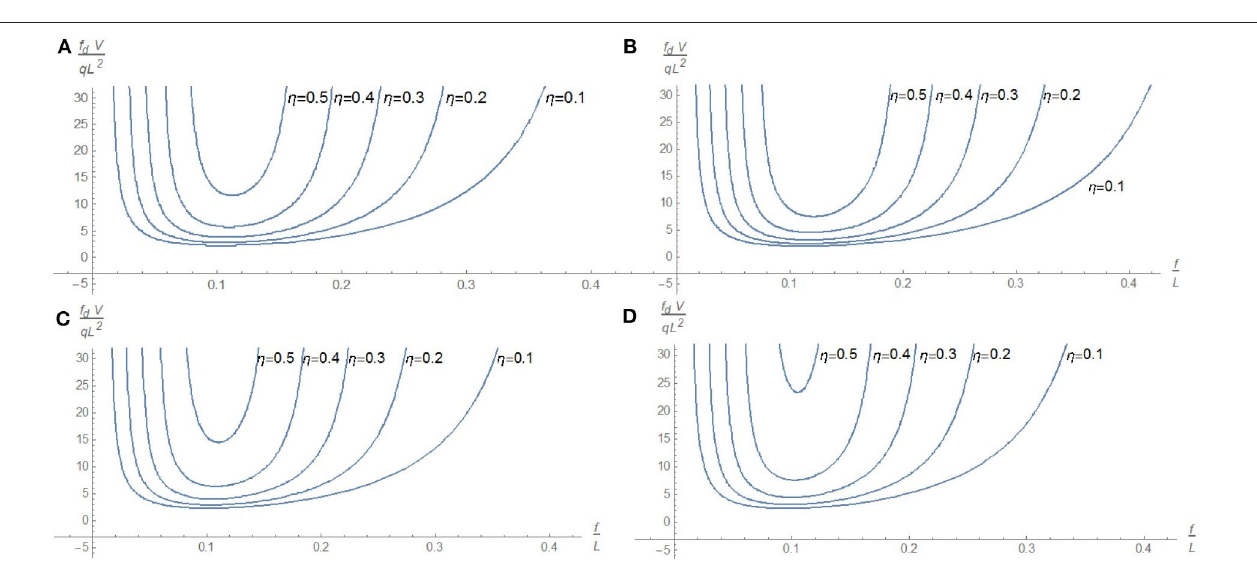
FIGURE 4 | Dimensionless volume f d V / qL 2 versus f/L for λ = 600: (A) k = 0, (B) k = 10, (C) k = 50, and (D) k =